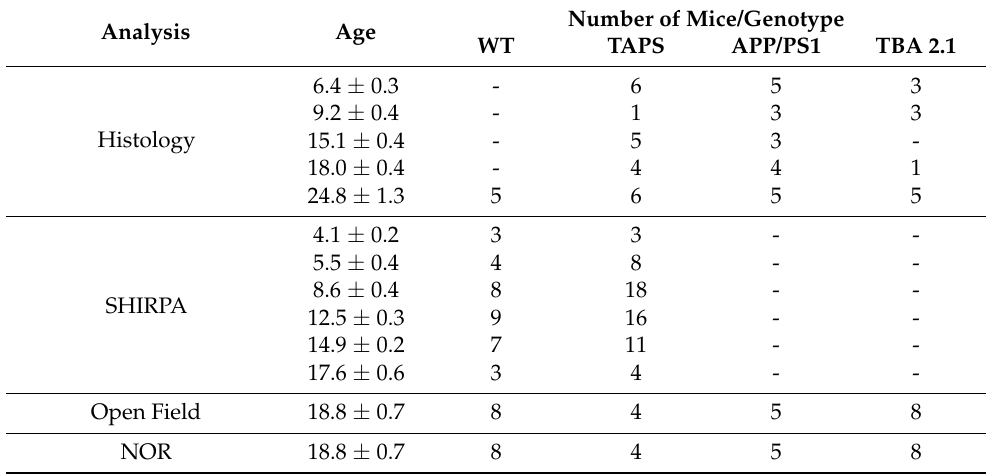
Table 1. Number of mice used for each analysis according to genotype and age. MWM, Morris water maze; NOR, novel object recognition test; WT,